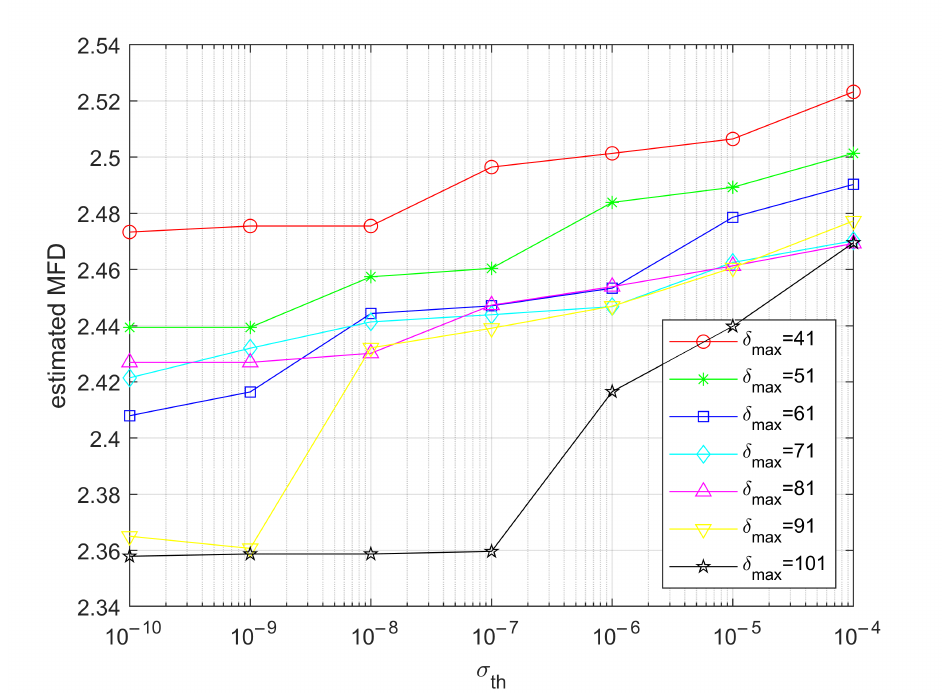
Figure 13. The estimated multi-spectral fractal dimension as a function of σ th for the low generated complexity ( H = 0.9) multi-spectral fractal